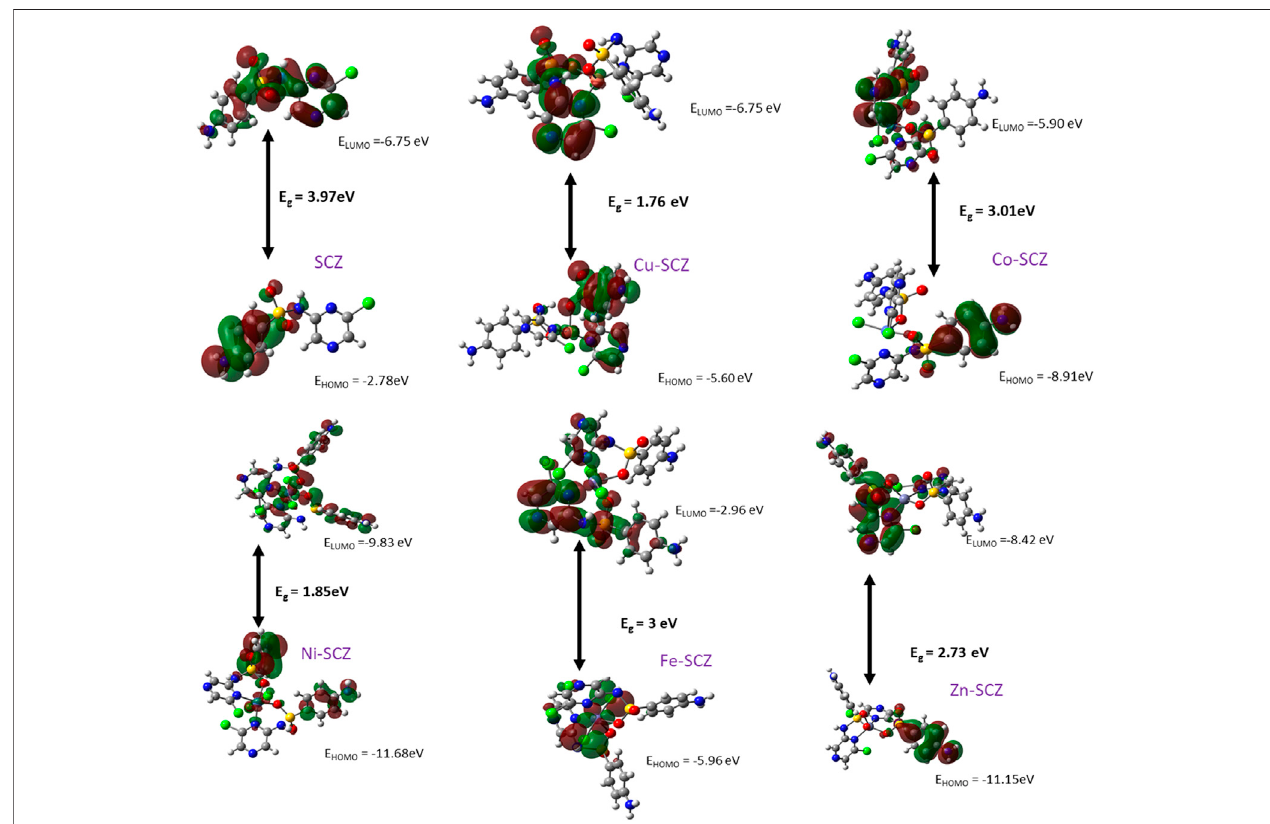
FIGURE 6 | HOMO and LUMO plots of the SCZ and the metal complexes using DFT/B3LYP.